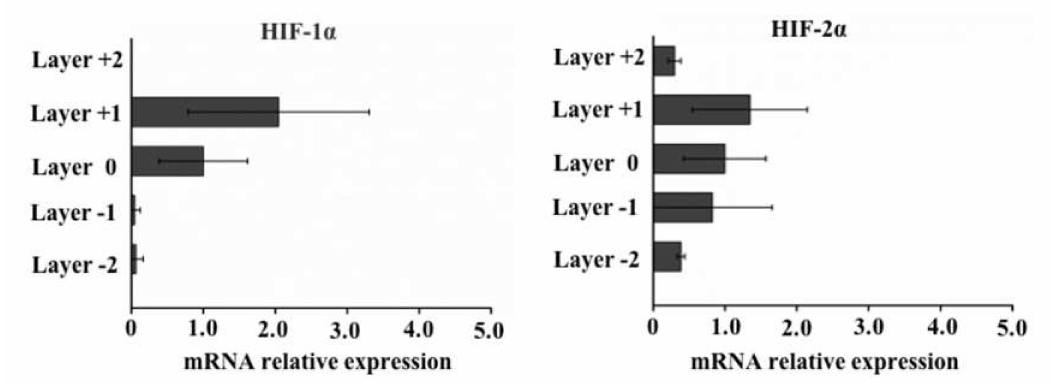
Figure 4. Relative expression hypoxia markers measured by quantitative PCR analysis. Real-time PCR-quantified levels of expression of hypoxia-inducible factor 1-alpha (HIF-1 α ) and hypoxia-inducible factor 2-alpha (HIF-2 α ) using 2- ∆∆ Ct values relative to glyceraldehyde-3-phosphate dehydrogenase (GAPDH) as an internal control. Error bars represent the standard deviation for 24 replicate